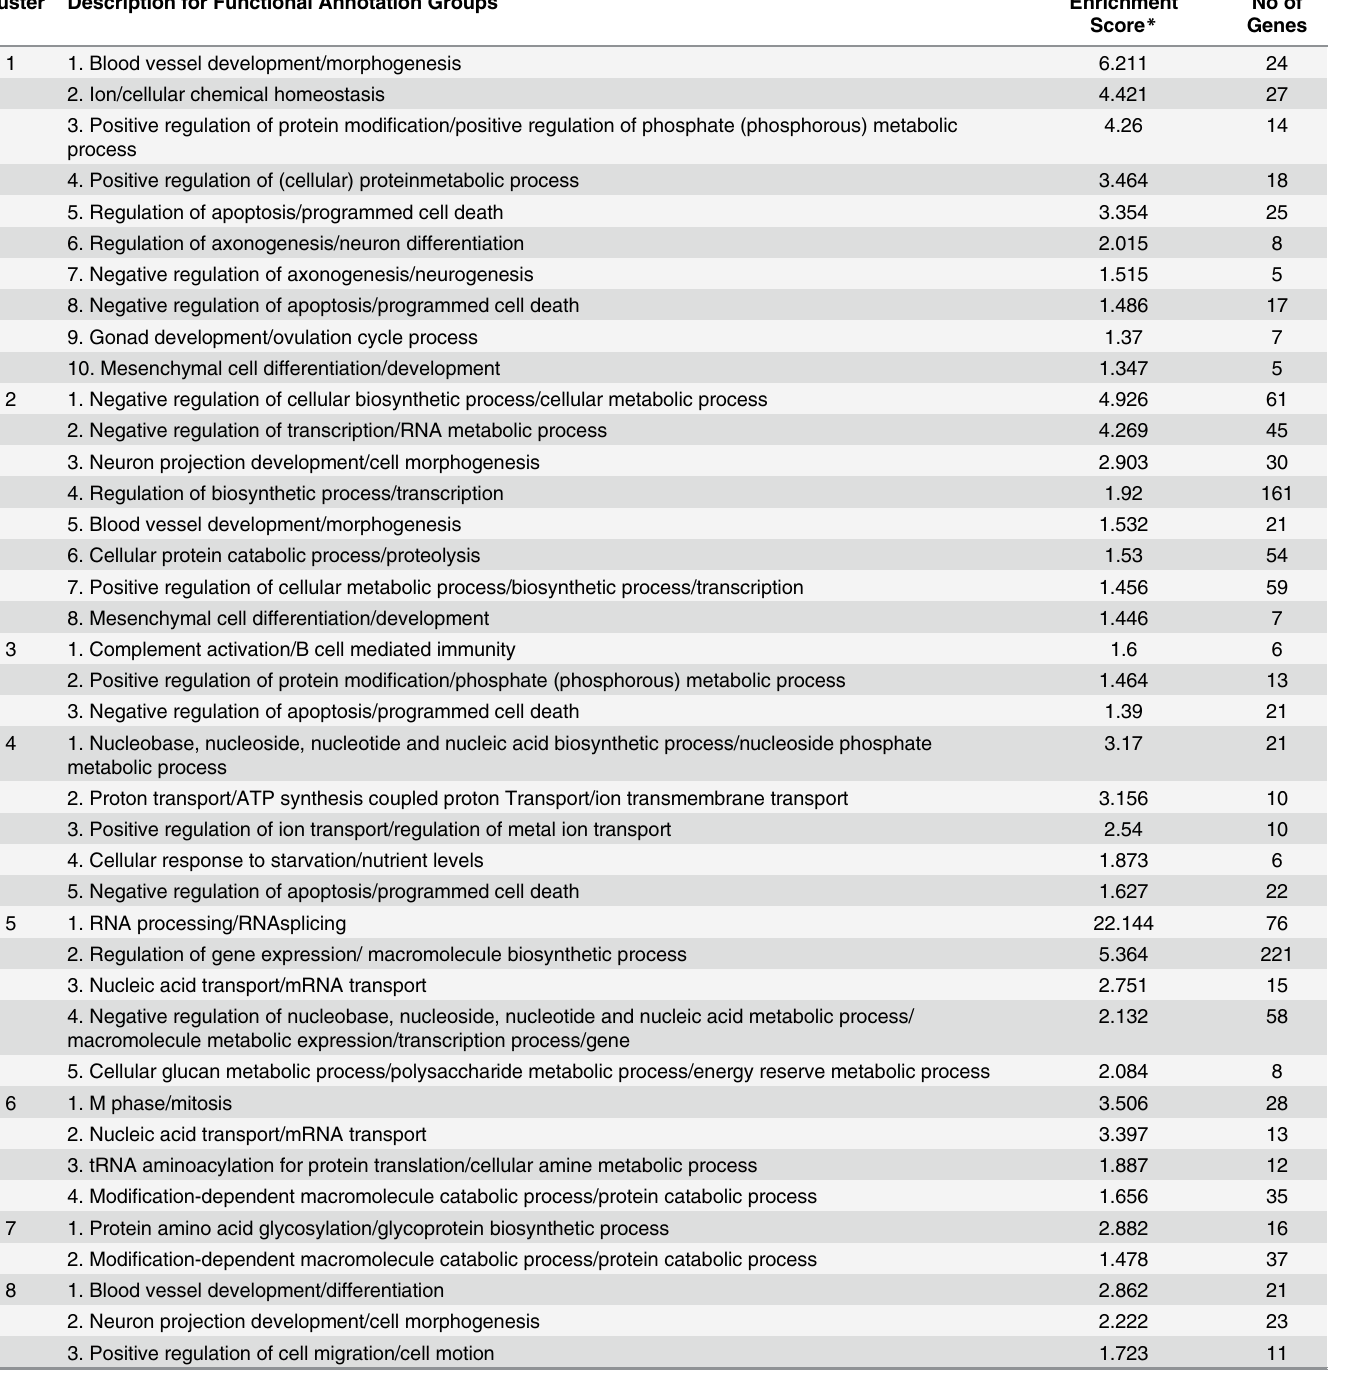
Table 3. List of enriched functional annotation groups in 8 clusters by functional annotation clustering analysis. Cluster Description for Functional Annotation